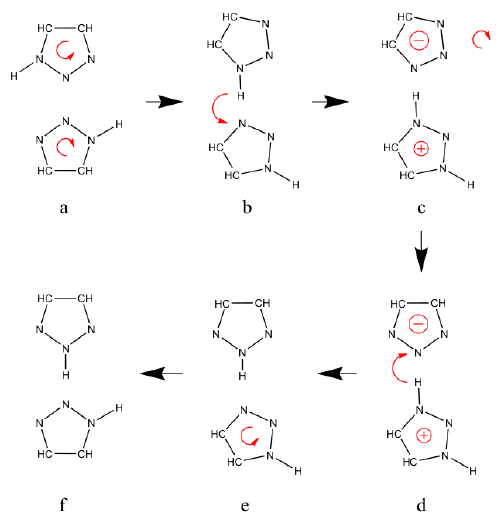
Figure 9. Detailed description of the third step of Figure 5. Step ( a ) is the starting configuration which undergoes a rotation resulting in the orientation of step ( b ). Proton donation leads to two charged species seen in step ( c ). Afterwards the negative charged species rotates backwards and gets its hydrogen back (step ( d )). The lower triazole rotates back in step ( e ) and as a result, step ( f ) equals the configuration of step 1 of Figure 5.